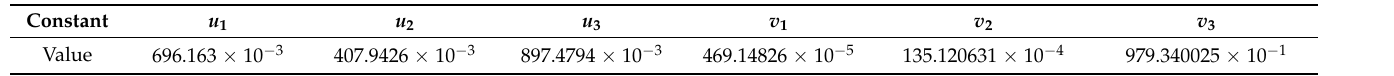
Figure 1. Cross-section of the proposed RI sensor based on a photonic crystal fiber coated with a graphene layer. Table 1. Summary of Sellmeier constants and their